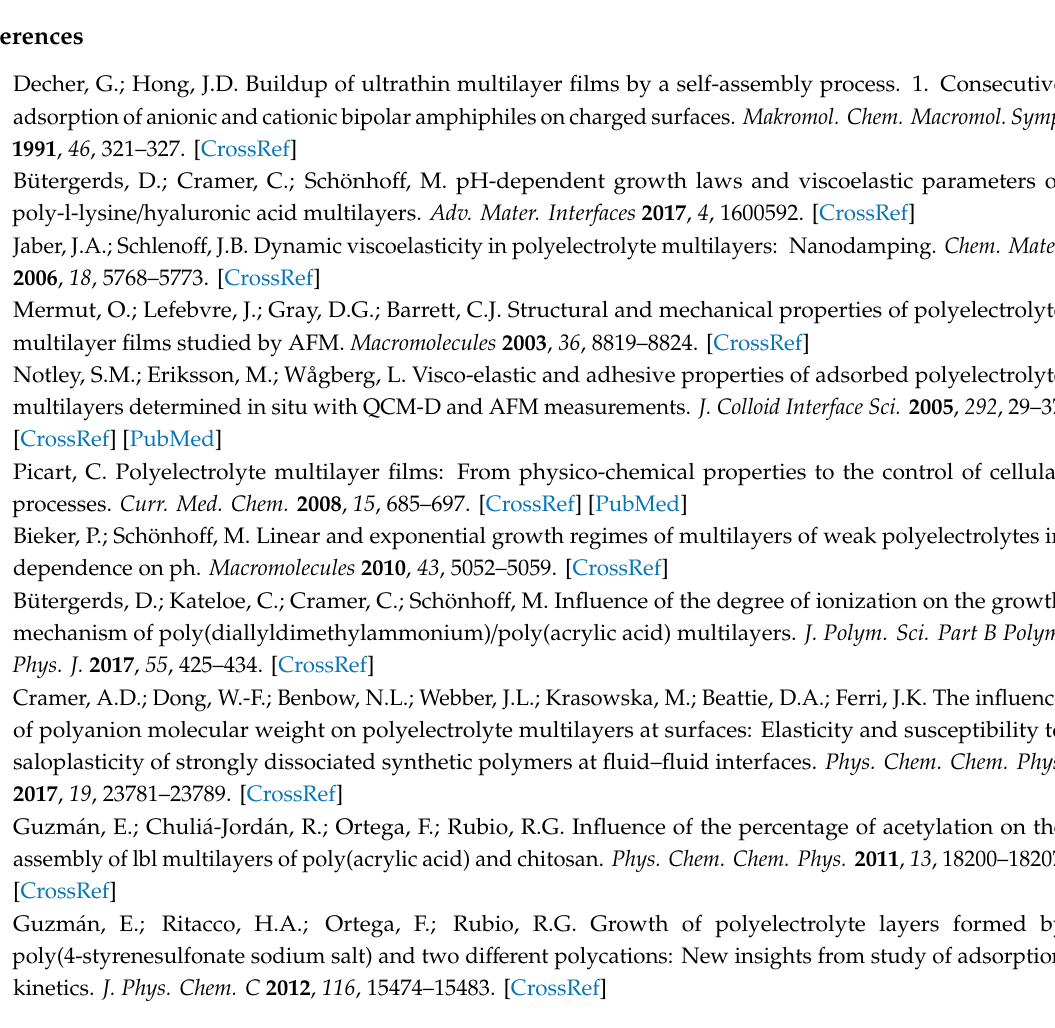
Figure S1: QCM-D time traces upon reversible swelling of PEM with ionic liquid solutions, Figure S2: the sensitivity of the modeling on the fluid viscosity and Figure S3: the ratio of dissipation to frequency vs. ionic liquid concentration used for PEM